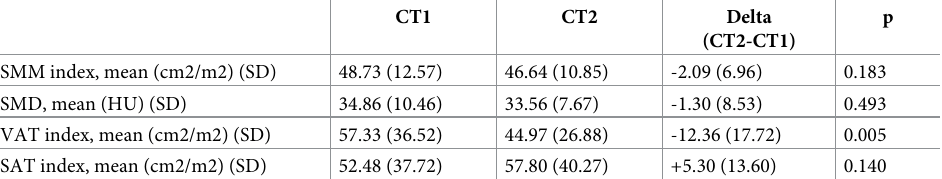
Table 3. Body composition alterations between initial assessment and late assessment (n =